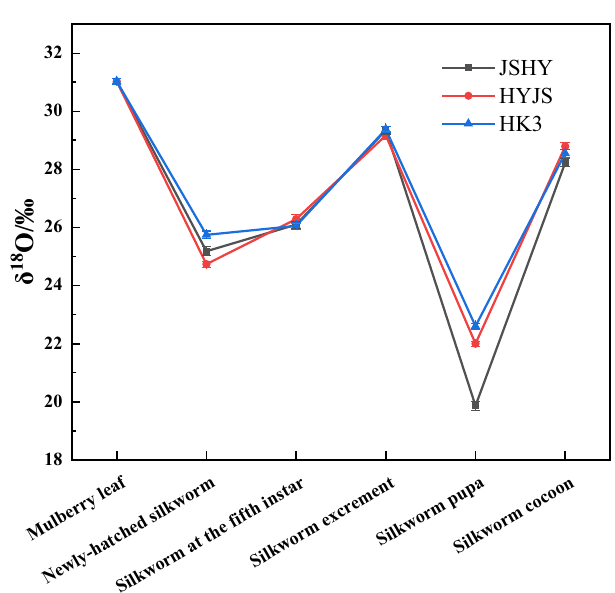
Figure 4. Line chart of oxygen stable isotope ratios in